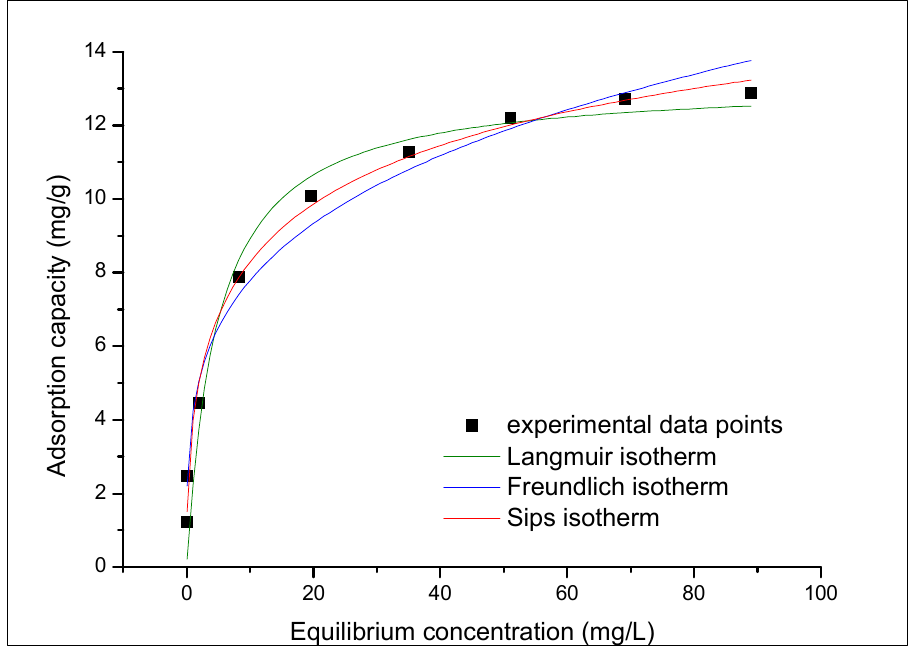
Figure 12. Adsorption isotherms. Table 5. Parameters of isotherm model for adsorption of Au (III) onto BCb/BC.